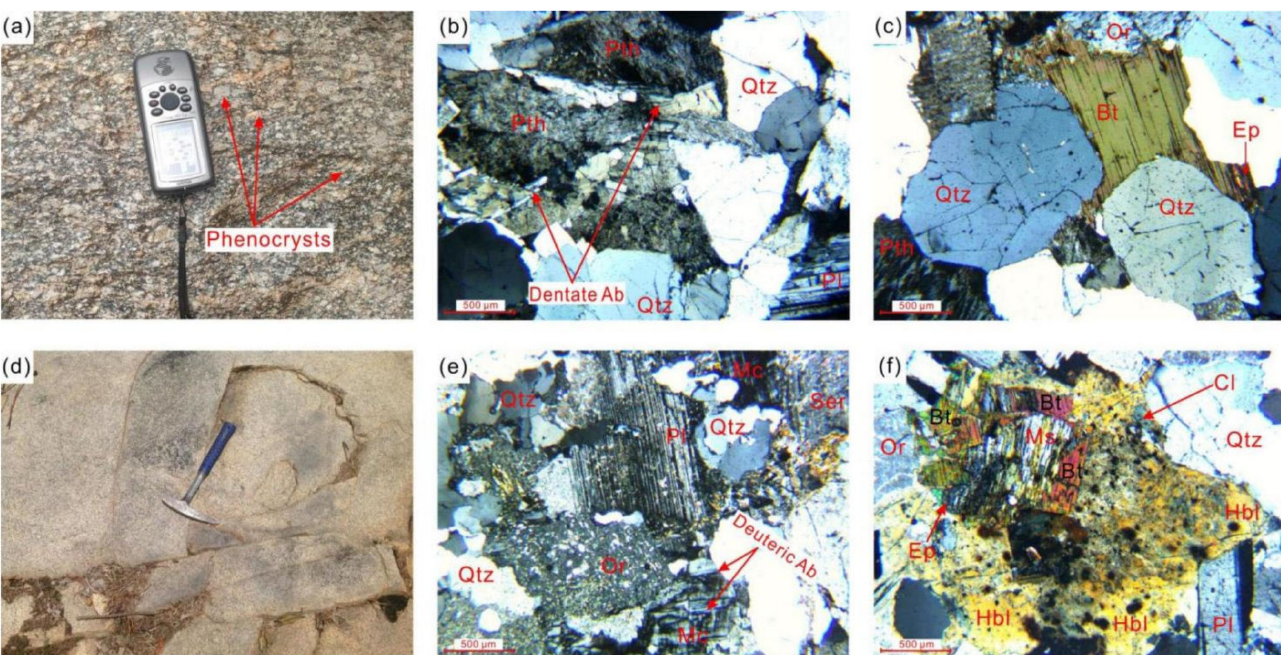
Figure 5. Photographs of hand specimens and microphotographs of Younger Granite (YG, includ- ing granite porphyry and biotite granite) from the Gindi Akwati deposit. ( a – c ) granite porphyry; ( d – f ) biotite granite. Ab = albite, Ep = epidote, Hbl = hornblende, Pth =